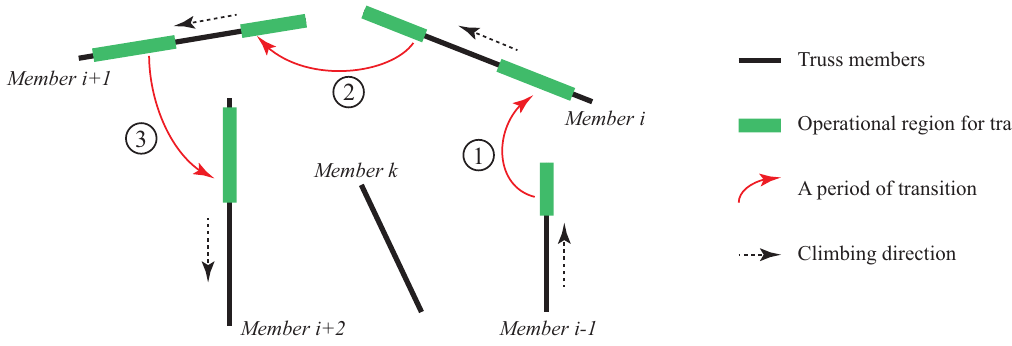
Figure 3. An illustration of global path for BiCRs traveling on a